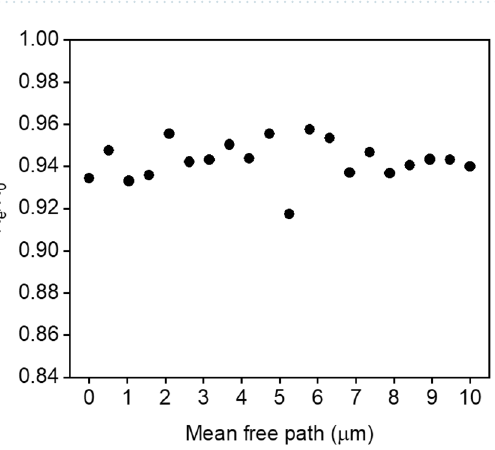
Figure 6. ( a ) PL spectra of the powders showing the Nd 3+ transitions 4 F 3/2 → 4 I 9/2 , 4 F 3/2 → 4 I 11/2 and 4 F 3/2 → 4 I 13/2 . ( b ) Temporal behavior of the 1068 nm PL signal, that corresponds to transition ( 4 F 3/2 → 4 I 11/2 ), for all samples.